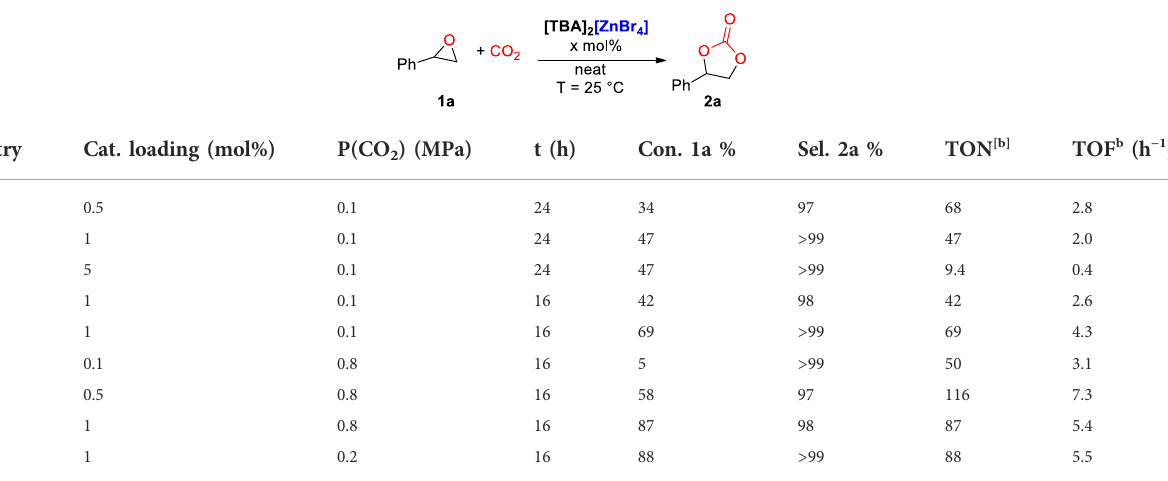
TABLE 4 Cycloaddition of CO 2 to styrene oxide: Effect of the catalyst loading a .